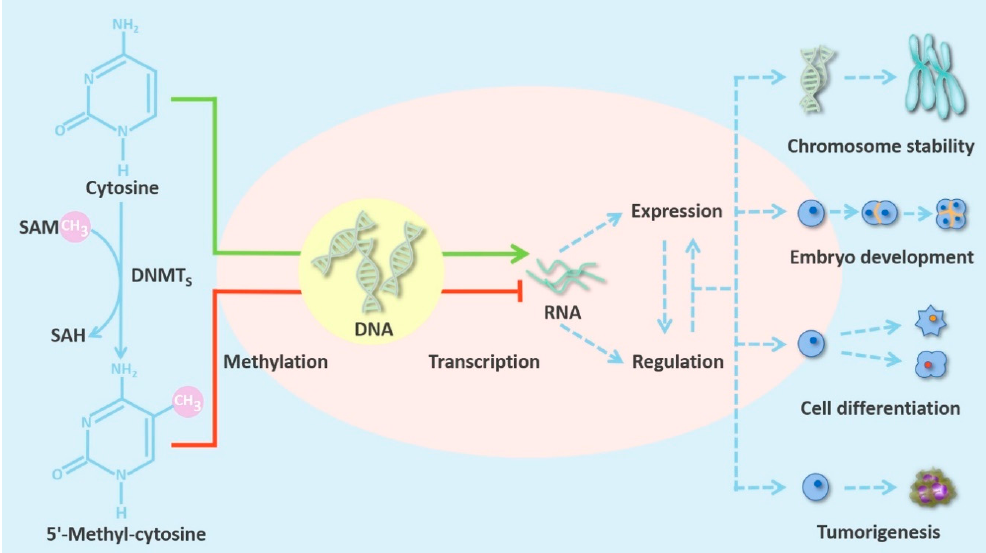
Figure 1. The characteristics of DNMTs in mammalian cells. DNMTs catalyze DNA methylation, which alters patterns of gene regulation and expression. This in turn affects chromosome stability, embryo development and cell differentiation. Aberrant DNMTs can induce tumorigenesis.